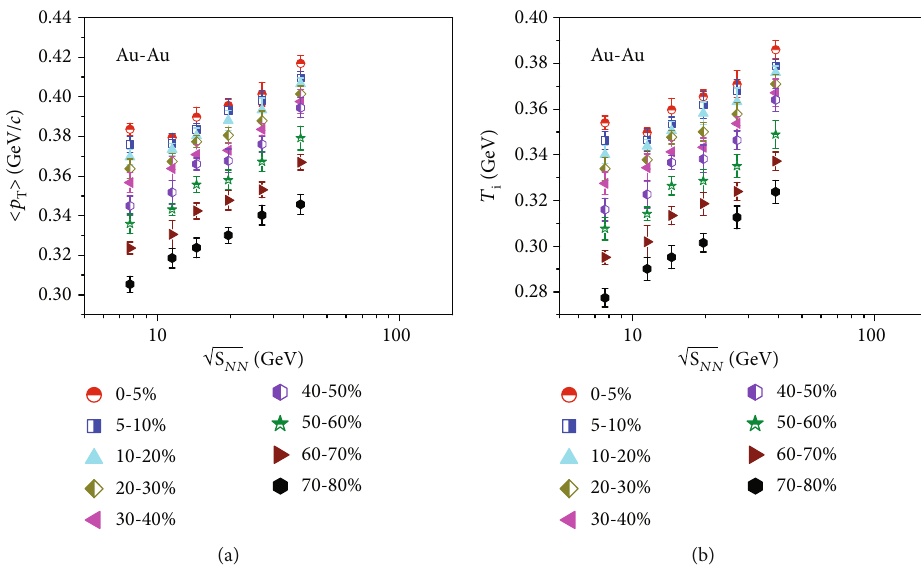
ffiffiffiffiffiffiffiffiffi p i and (b) T s NN for di ff erent event centralities. The di ff erent symbols display i on T